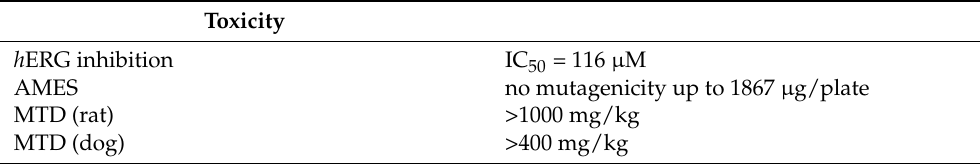
Table 6. h ERG inhibition, mutagenicity and maximum tolerated dose of 11o